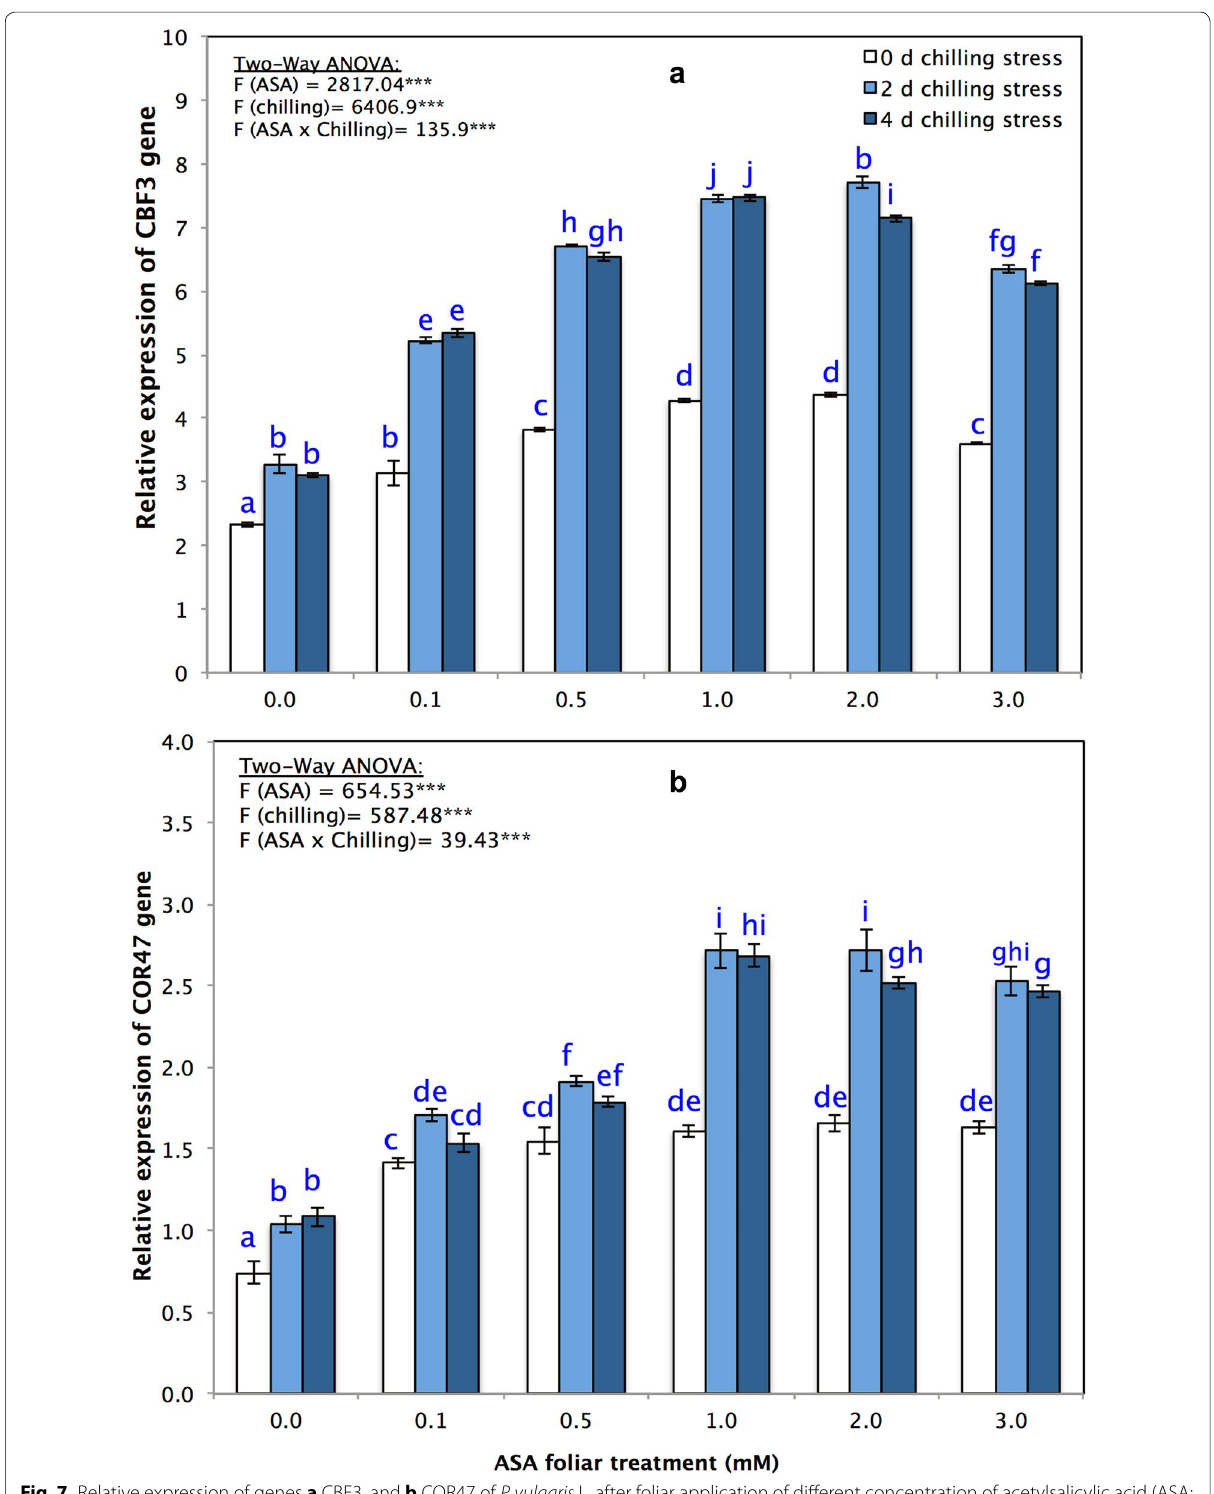
Fig. 7 Relative expression of genes a CBF3, and b COR47 of P. vulgaris L. after foliar application of different concentration of acetylsalicylic acid (ASA; 0, 0.1, 0.5, 1, 2, 3 mM) and exposed to a different level of chilling stress (0, 2, 4 days). Data represented are mean of two replicates tion. Variations between different chilling stresses and foliar ASA concentration were assessed by univariate analyses followed by post hoc analysis. Means with the same letters are not significantly different according to Duncan’s multiple